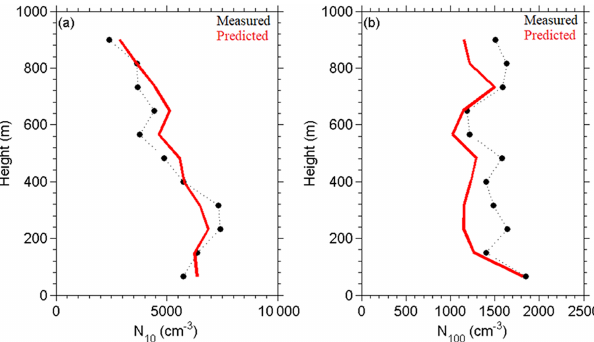
Figure 9. Comparison of predicted PMCAMx-UF (red line) vs. ob- served (black dots) vertical profiles of averaged particle number concentrations for (a) N 10 and (b) N 100 of 25 flights over the Po Valley during the PEGASOS